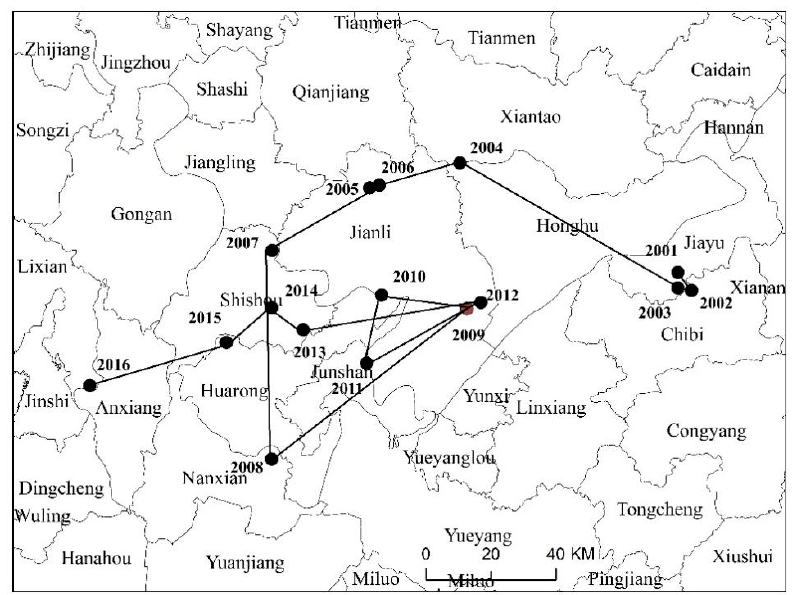
Figure 3. Spatial evolution trend of green development efficiency center of the paper industry in Yangtze River Economic Belt.